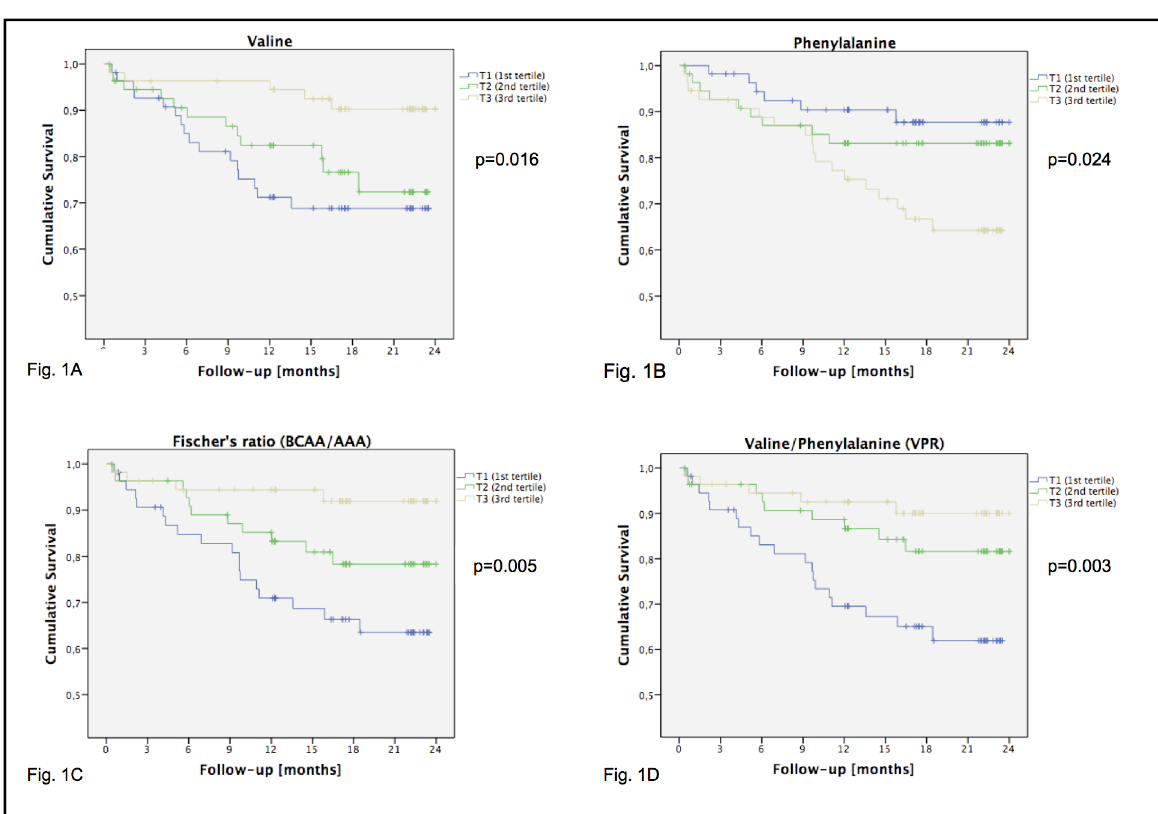
Fig 1. Cumulative survival according to Kaplan-Meier for chosen variables (N = 166). Presented p-values are from global Log- Rank tests. Maximum follow-up was 24 months. T1 (blue): group below the 33rd percentile. T2 (green): group within the 33rd and 67th percentile. T3 (yellow): group above the 67th percentile. BCAA: Branched-chain amino acids, sum of valine, leucine and isoleucine. AAA: Aromatic amino acids, sum of phenylalanine, tyrosine and